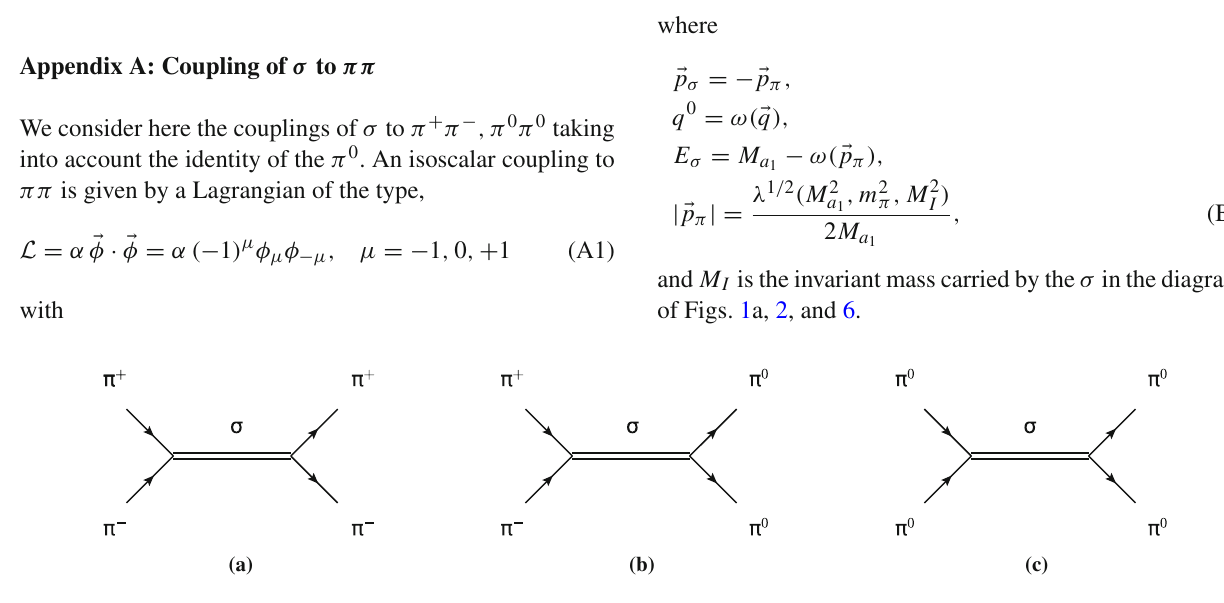
Fig. 6 Amplitudes ππ → ππ through an isoscalar